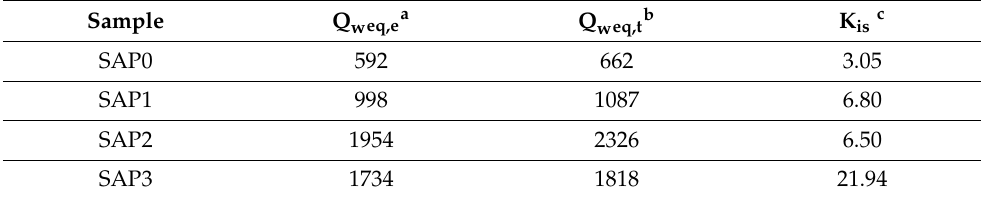
Table 1. Swelling kinetic parameters of SAP0, SAP1, SAP2, and